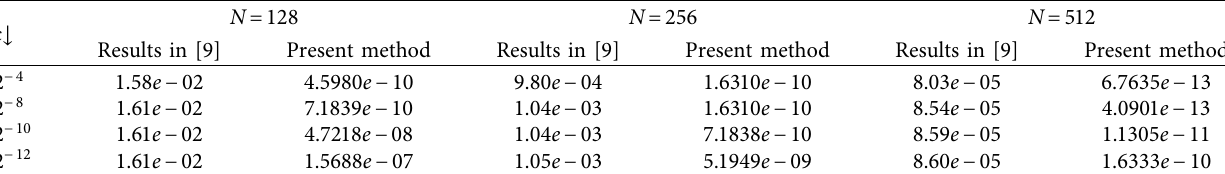
Table 3: Comparison of maximum absolute errors for Example 2.